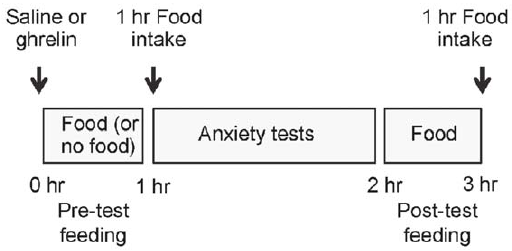
Figure 2. Protocol for anxiety-related studies. Fed rats were injected with saline or ghrelin directly into the amygdala at time zero. In the FOOD ACCESS paradigm, rats were allowed access to food during the first hour after injection whereas food access was denied in the FOOD WITHHELD paradigm. After this, all rats underwent tests exploring anxiety-like behaviour, first in the EPM test (5 min) and then in the open field test (40 min). Afterwards all the rats were returned to their home cages and post-test food intake measured for 1 hr (corresponding to time 2–3 hr after injection).